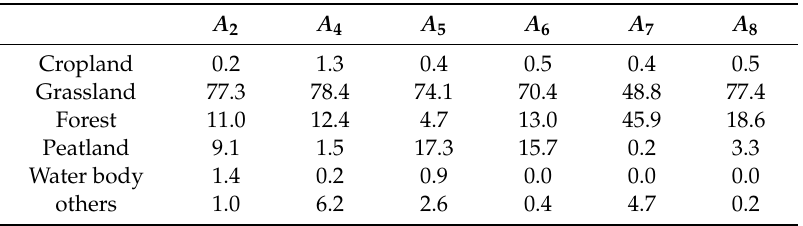
Table 1. Percent of each land cover type of the overlapped area within the study area and each